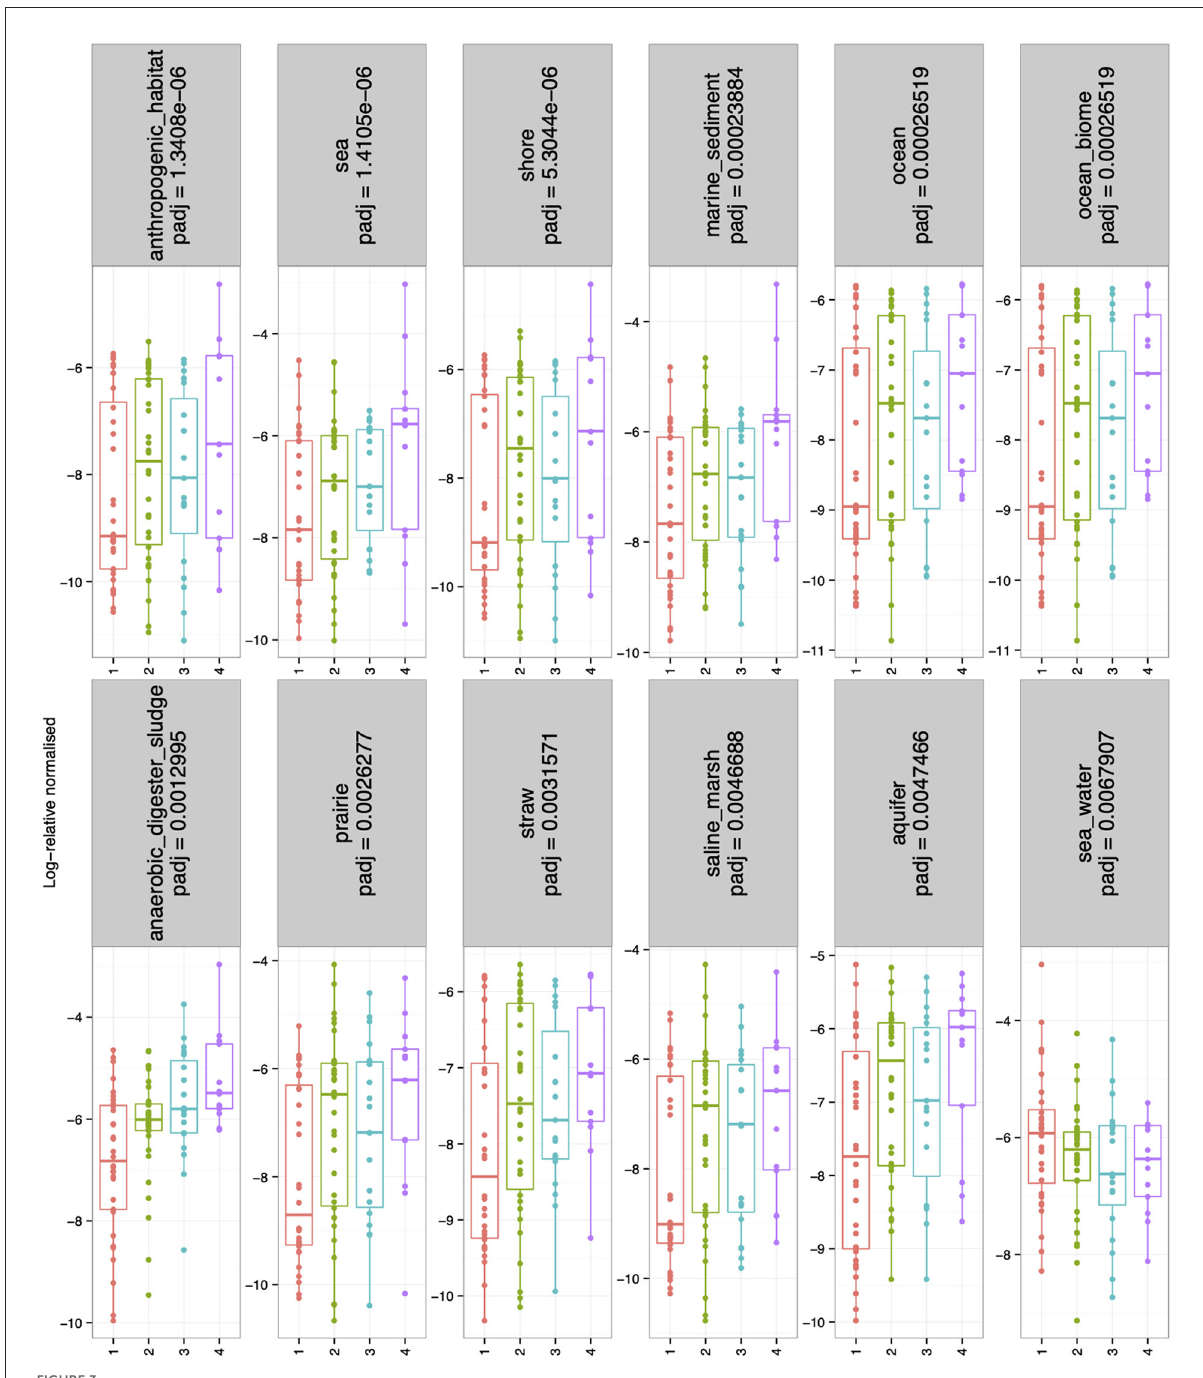
FIGURE3 Boxplots showing the environmental ontology (EnvO) terms returned from the seqenv pipeline that were log-2 fold differentially abundant for the combined pit latrine samples at sampling depths 1, 2, 3, and 4. Depth 1 = 20cm, Depth 2 = 40cm, Depth 3 = 60cm, and Depth 4 = 80cm.